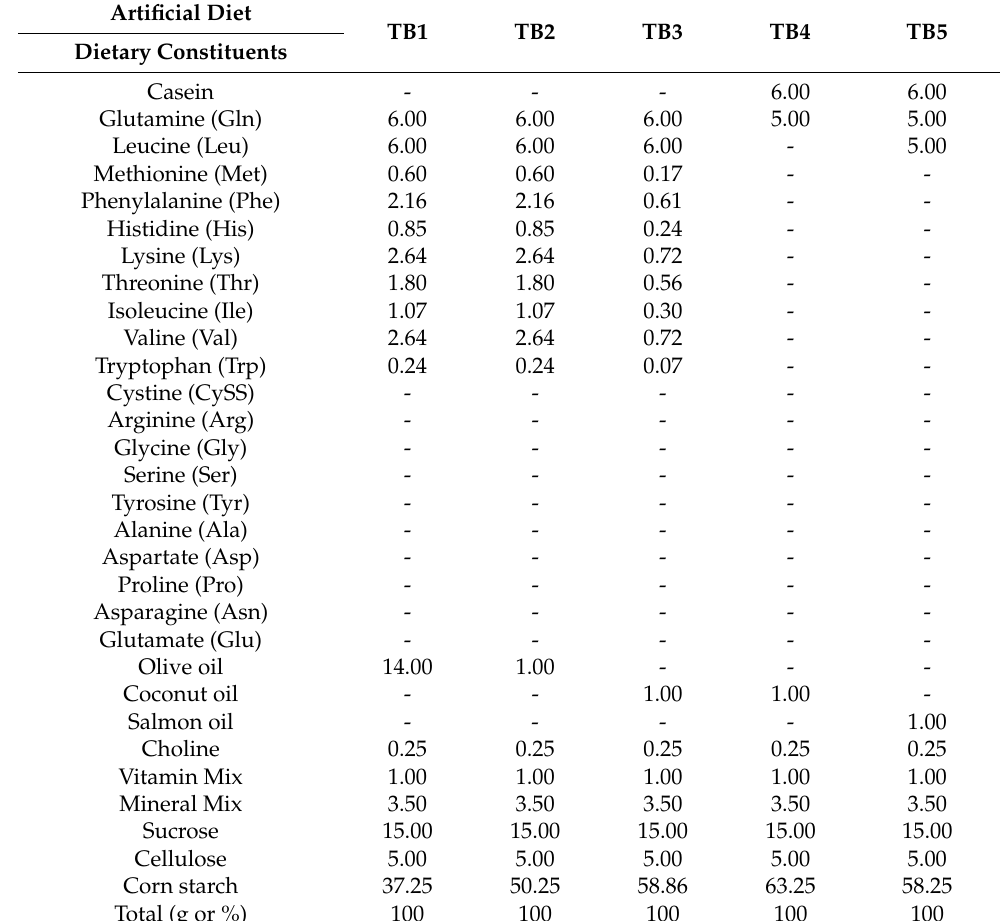
Table 2. Composition of artificial diets (g/100 g